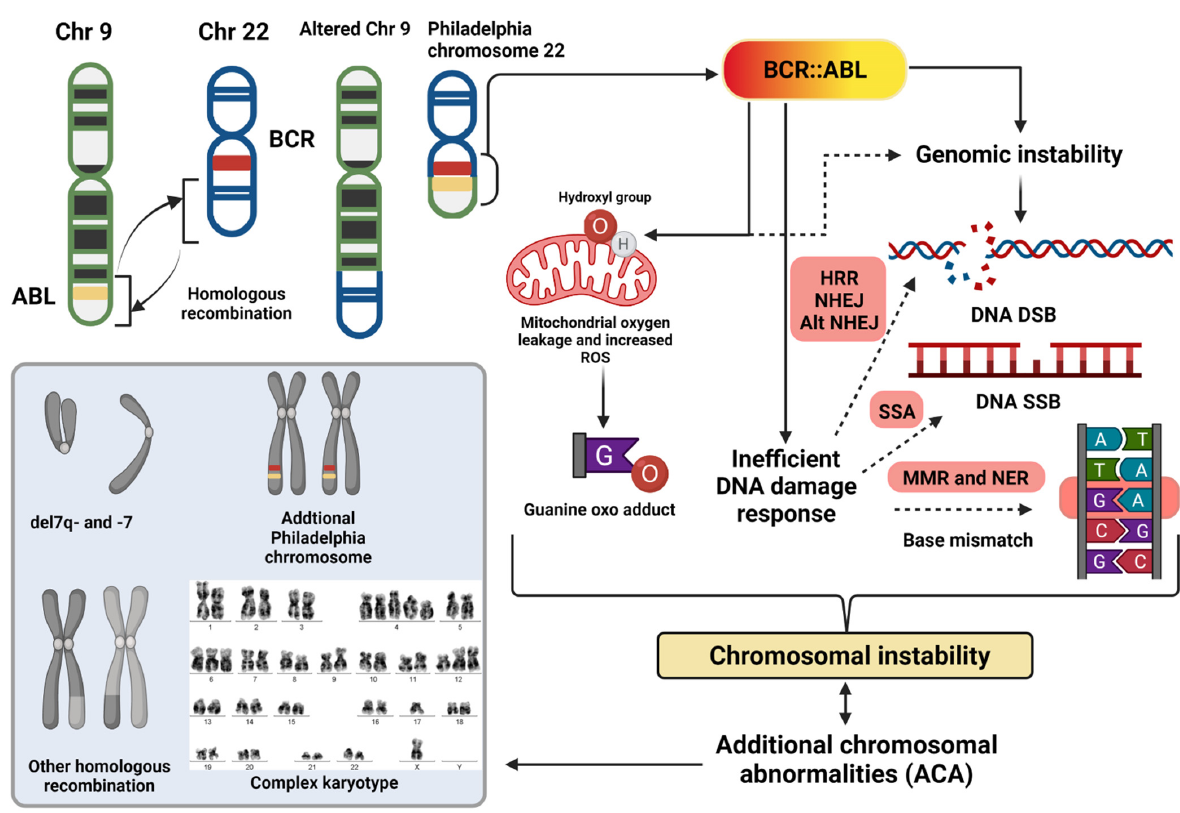
Figure 1. Mechanisms and effect of chromosomal instability in CML. The BCR::ABL fusion oncoprotein leads to a state of genomic instability, along with multiple metabolic changes in the cells, leading to increased production of reactive oxygen species (ROS). There is an increased sensitivity to ROS in the cellular microenvironment in view of defective assessment of genetic stress and aber- rations, and a skewed DNA damage response towards error-prone repair pathways such as NHEJ and alternate NHEJ. These ultimately lead to multiple chromosomal changes, such as point muta- tions in the DNA affecting the genetic and epigenetic pathways alike. Additional chromosomal ab- normalities, not limited to the changes in the above figure, are a fallout of these pathological pro- cesses which further destabilize the genome. These intertwined steps promote leukemogenesis through proliferation advantage, inhibition of apoptosis, and differentiation block, which results in CML developing more TKI resistance and progression to the advanced phases. G—guanine; A—ade- nine; T—thymine; C—cytosine; O—oxygen radical; HRR—homologous recombination repair; NHEJ—non ho- mologous end joining; alt NHEJ—alternate pathway of NHEJ; SSA—single-strand annealing; MMR—mismatch repair; NER—nucleotide excision repair; DNA DSB—DNA double-strand breaks; and SSB—single-strand breaks. 2.2. Causes of Chromosomal Instability We discussed the wide effect of chromosomal instability manifesting as ACAs in CML treatment resistance progression. Chromosomal instability in CML stems from the underlying overactive tyrosine kinase pathway as has been mentioned in the previous section. Multiple mechanisms are at interplay in perpetuating this pathology and we sum- marize a few of them below. 2.2.1. Reactive Oxygen Species CML cells have a higher production rate of reactive oxygen species (ROS), due to altered mitochondrial membrane potential and transfer of electrons along the